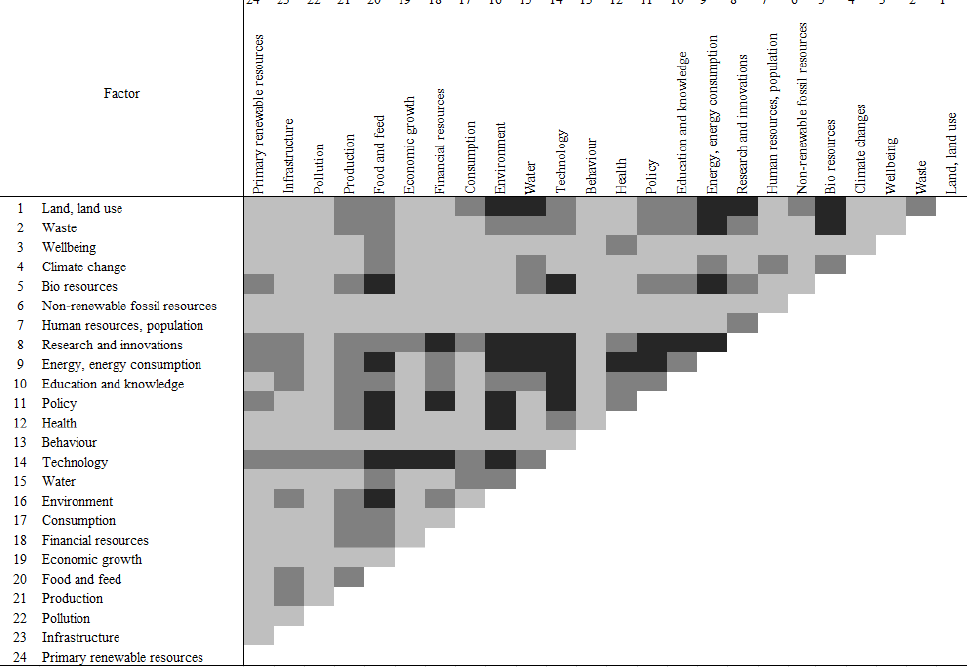
Fig. 4. Common interaction links in both